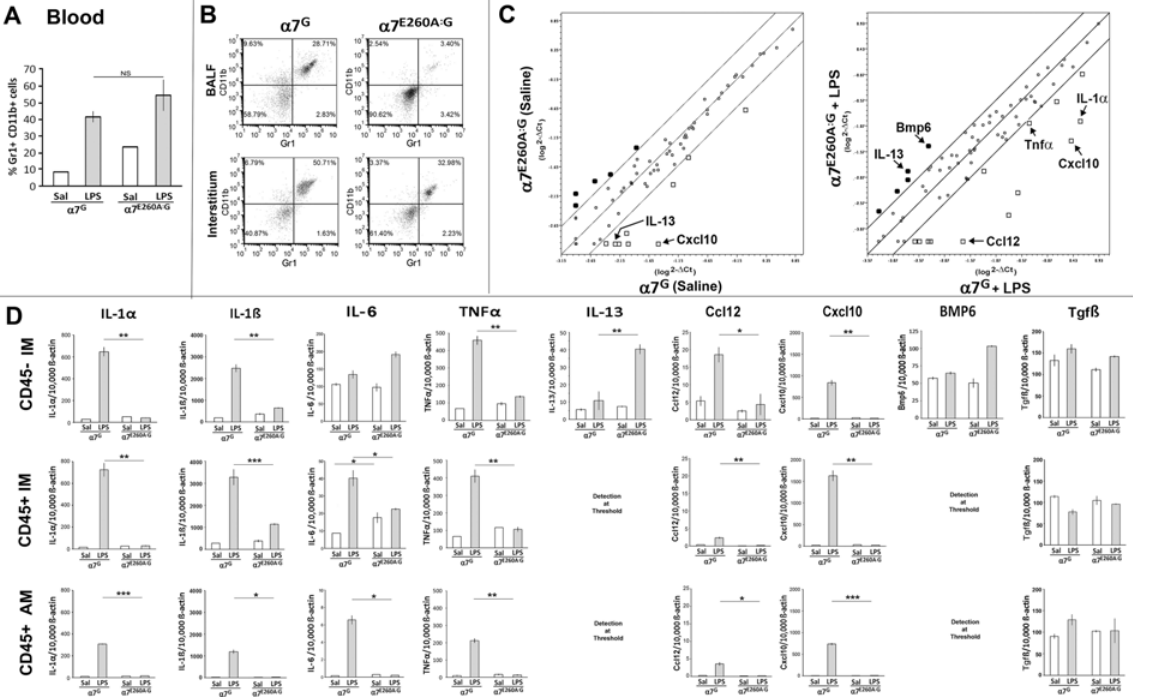
Fig 6. Gene expression analysis of lung cells from α 7 G or α 7 E260A+/+:G mice. Mice were i.n. challenged with either saline or LPS and harvested 18 – 20 hrs later. (A) Blood was collected at 18 hrs post-saline or LPS challenge to determine the number of Gr1 + CD11b + cells present. Error bars reflect +/- SEM. NS is non-significant as determined by the Student ’ s t-test. (B) BALF cells were isolated following lung lavage and interstitial cells were obtained from the digested lung tissue. A sample of these cells preparations were analyzed by flow cytometry for the presence of Gr1 + CD11b + cells. Note the substantial decrease in response in the α 7 E260A:G double-positive cell populations compared to the control. (C) RNA was isolated from the remaining cells in these groups and tested for cytokine and chemokine transcripts using a SABioscience gene array kit (see Methods). The boundary lines shown indicate a difference of 4-fold in transcript number. Some points are identified are indicated. (D) In separately performed experiments the changes in RNA expression as indicated in (C) were confirmed using specific real-time PCR primer analysis (taqMan probes; see Methods). Results are presented as transcripts per 10,000 beta-actin transcripts. * p < 0.05, ** p < 0.01, *** p < 0.001.